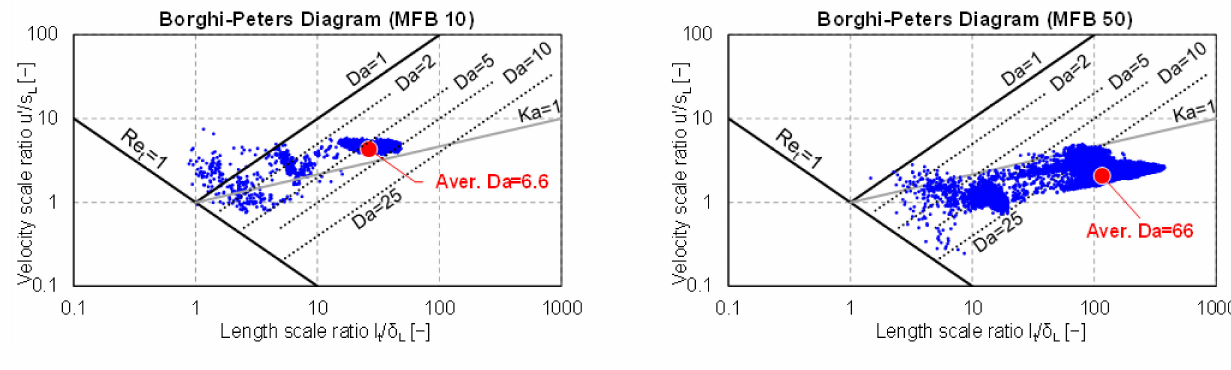
Figure 1. Mean (red point) and local (blue dots) turbulence–flame interaction at 10% ( left ) and 50% ( right ) burnt fraction in a spark ignition (SI) engine from [30]. Data are conditioned on the flame brush (0.05 < (cid:101) c <